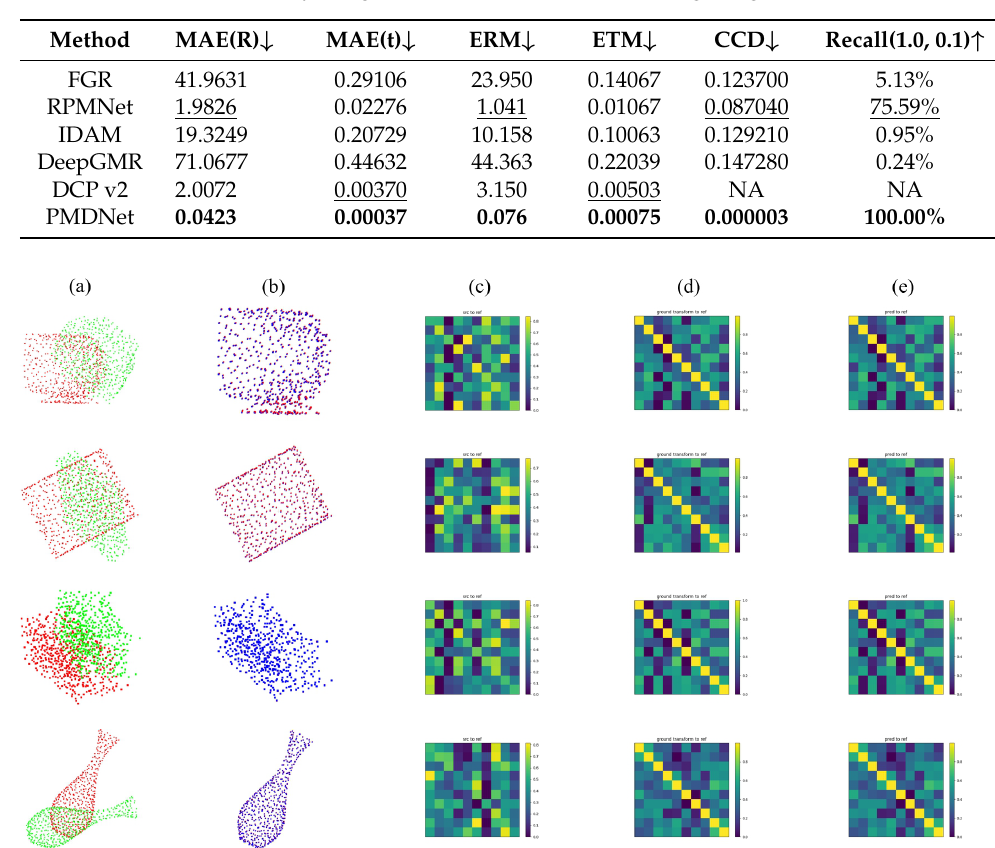
Table 6. Results on unseen data. Bold and underline denote best and second best performance. They are trained on the first twenty categories and tested on the remaining categories.